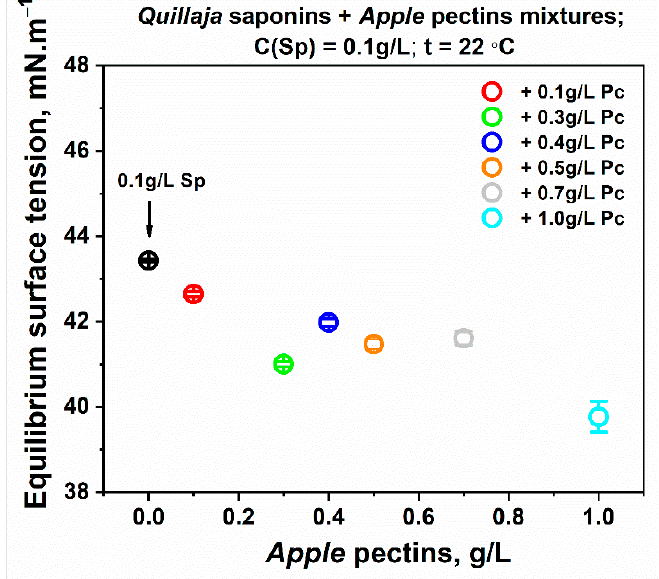
Figure 3. Equilibrium surface tension of Quillaja saponin and Apple pectin mixture solutions at constant saponin concentration (C(Sp) = 0.1 g/L) and at various pectin quantities.